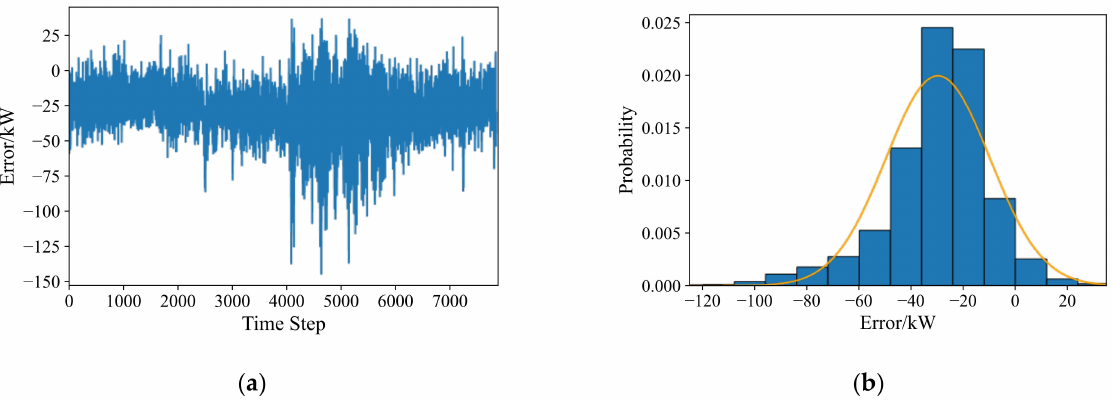
Figure 9. The error series and its distribution on the train set. ( a ) The error series on the train set. ( b ) The error series distribution on the train set.